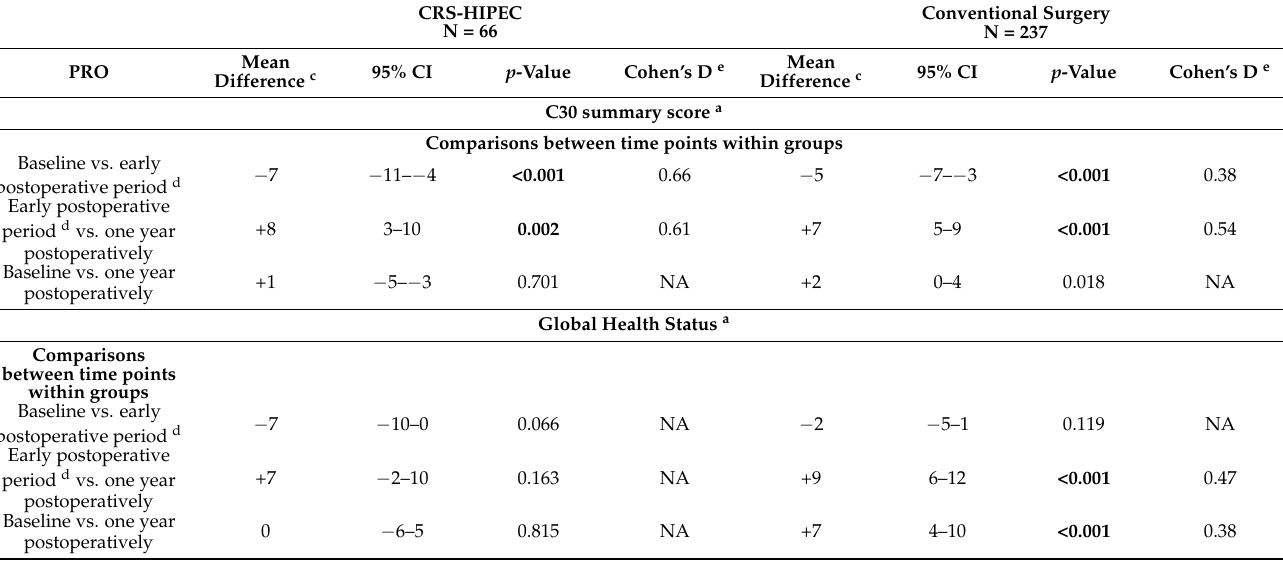
Figure 2. Comparison of predefined patient-reported outcomes between the CRS-HIPEC group and the conventional surgery group. Continuous lines represent mean PRO scores; dotted lines represent standard deviations of PRO scores. ( A ) C30 Summary score; ( B ) Global Health Status; ( C ) physical functioning; ( D ) role functioning; ( E ) emotional functioning; ( F ) cognitive functioning; ( G ) social functioning; ( H ) fatigue; ( I ) diarrhea. Table 3. Linear mixed modeling on comparisons of scores over time within the groups.